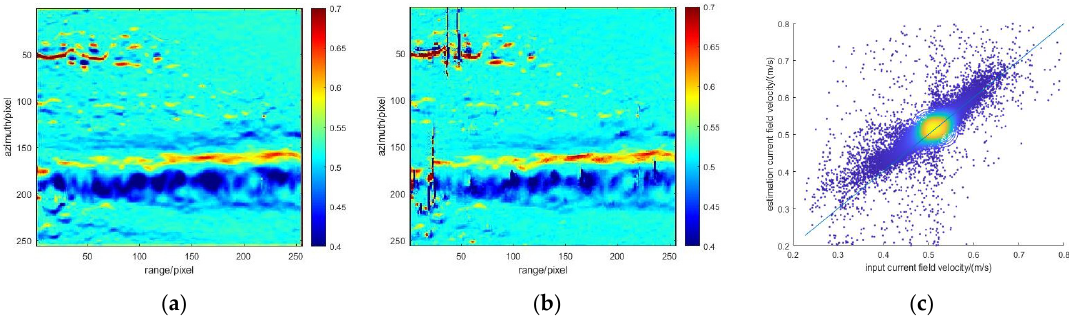
Figure 12. The velocity calculation results based on the direct method: ( a ) the input velocity, ( b ) the current velocity cal- culated directly from the interferometric phase, and ( c ) the scatter density map of the input and calculated current veloc- ities.